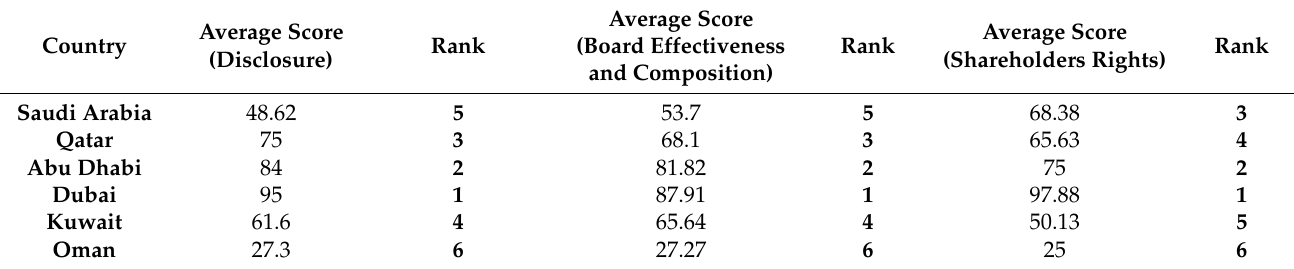
Table 4. Attribute scores: country